Question: Draft a figure caption describing what is shown.
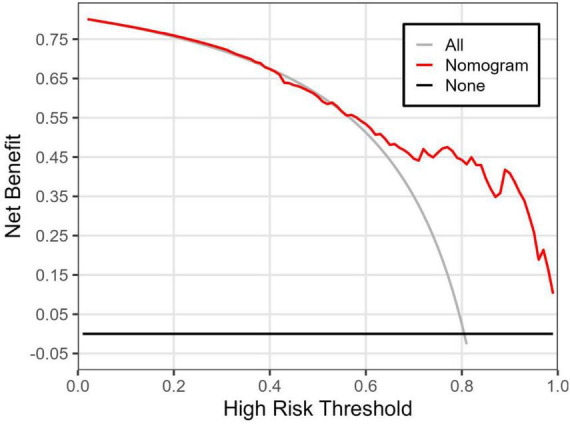
Answer: Decision curve analysis (DCA) of the frailty stratification model.